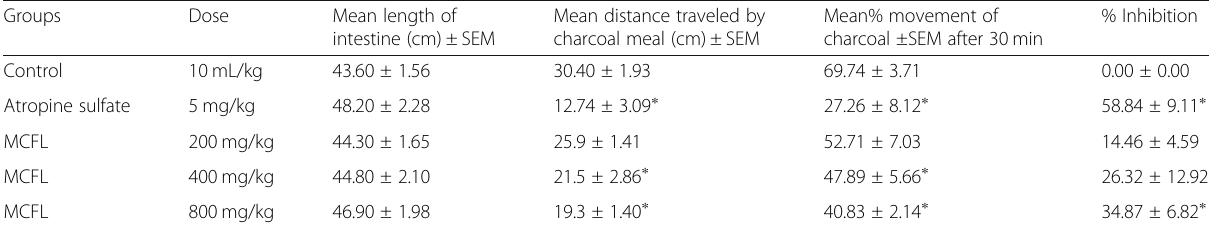
Table 3 Effect of MCFL on charcoal meal test Groups